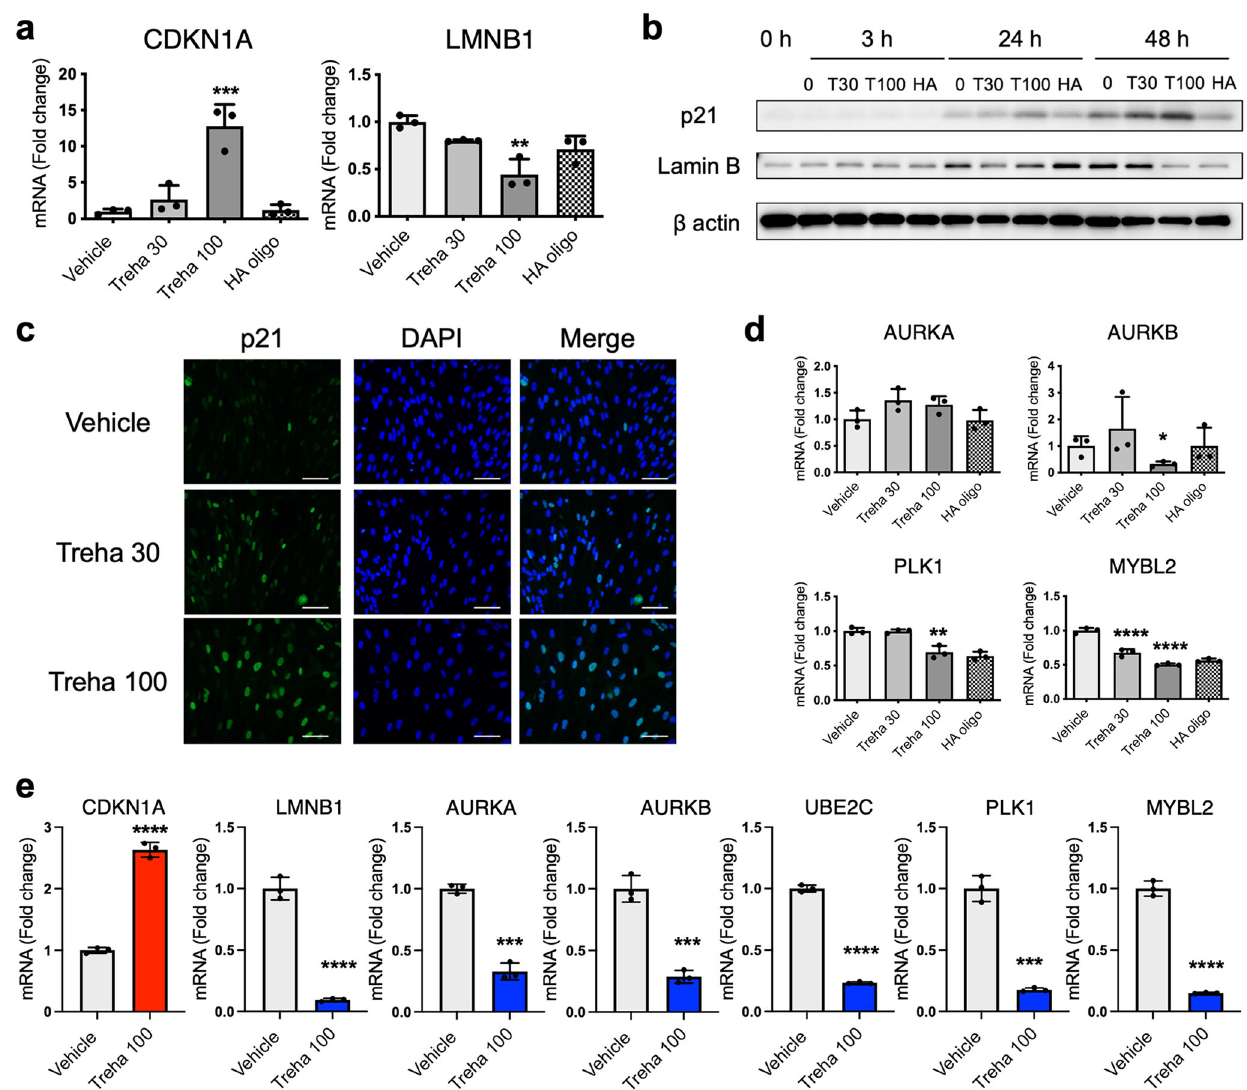
Fig. 4 Trehalose modulates the expression of senescence and cell cycle arrest-related molecules. a Human dermal fi broblasts were treated with trehalose (30 and 100 mg/ml), tetrasaccharide hyaluronan (HA oligo) (30 μ g/ml), or vehicle (PBS) for 24 h. CDKN1A and LMNB1 mRNA expression were assessed by qPCR. Data were shown as relative expressions to the control (vehicle-treated) fi broblasts. b Western blotting showing the expression of p21, lamin B, and β -actin in human dermal fi broblasts treated with trehalose (30 and 100 mg/ml) or the vehicle for 24 h. c Human dermal fi broblasts were treated with trehalose (30 and 100 mg/ml) or vehicle control (PBS) for 24 h. The cells were stained with antibodies for p21 (green) and DAPI (blue) for nuclei and were observed using a fl uorescence microscope. Scale bar = 100 μ m. d AURKA , AURKB , AURKC , MYBL2 , PLK1 , and UBE2C mRNA expressions were assessed by qPCR. Data were shown as the relative expression to the control (vehicle-treated) fi broblasts. e Trehalose (100 mg/ml) or vehicle (PBS) were added in the human dermal fi broblasts populated collagen gel for 72 h. CDKN1A , LMNB1 , AURKA , AURKB , UBE2C , PLK1 , and MYBL2 mRNA expressions were assessed by qPCR. Data were shown as relative expression to the control (vehicle-treated). * P < 0.05, ** P < 0.01, *** P < 0.001, and **** P < 0.0001 versus the vehicle-treated control group by one-way ANOVA ( a , d ) or Student t -test ( e ). Data were expressed as means ± SD for three wells ( a , d ) or three dermal substitutes ( e ), and are representative of three independent